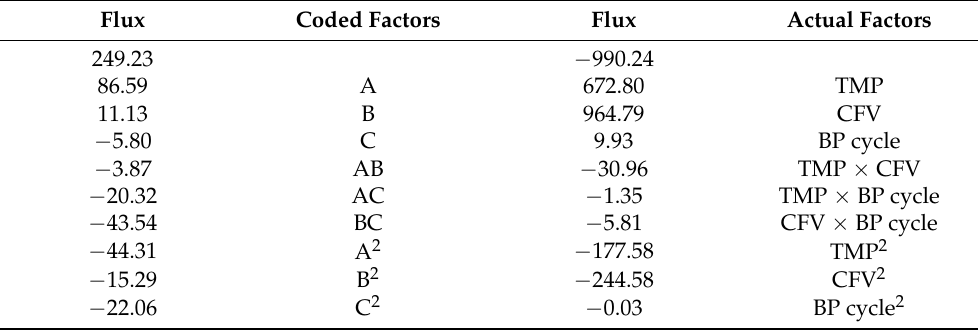
Table 9. Permeate flux-regression polynomial coefficients in terms of coded and actual factors.